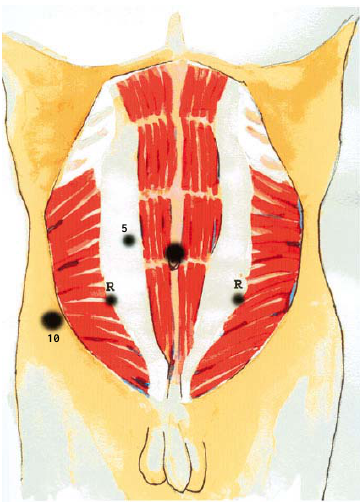
FIGURE 3. Port placements for the robotic technique used at the University of California at Irvine. (Figure reprinted from Surgical Endoscopy 18(12), 1694–1711, 2004. With kind permission of Springer Science and Business